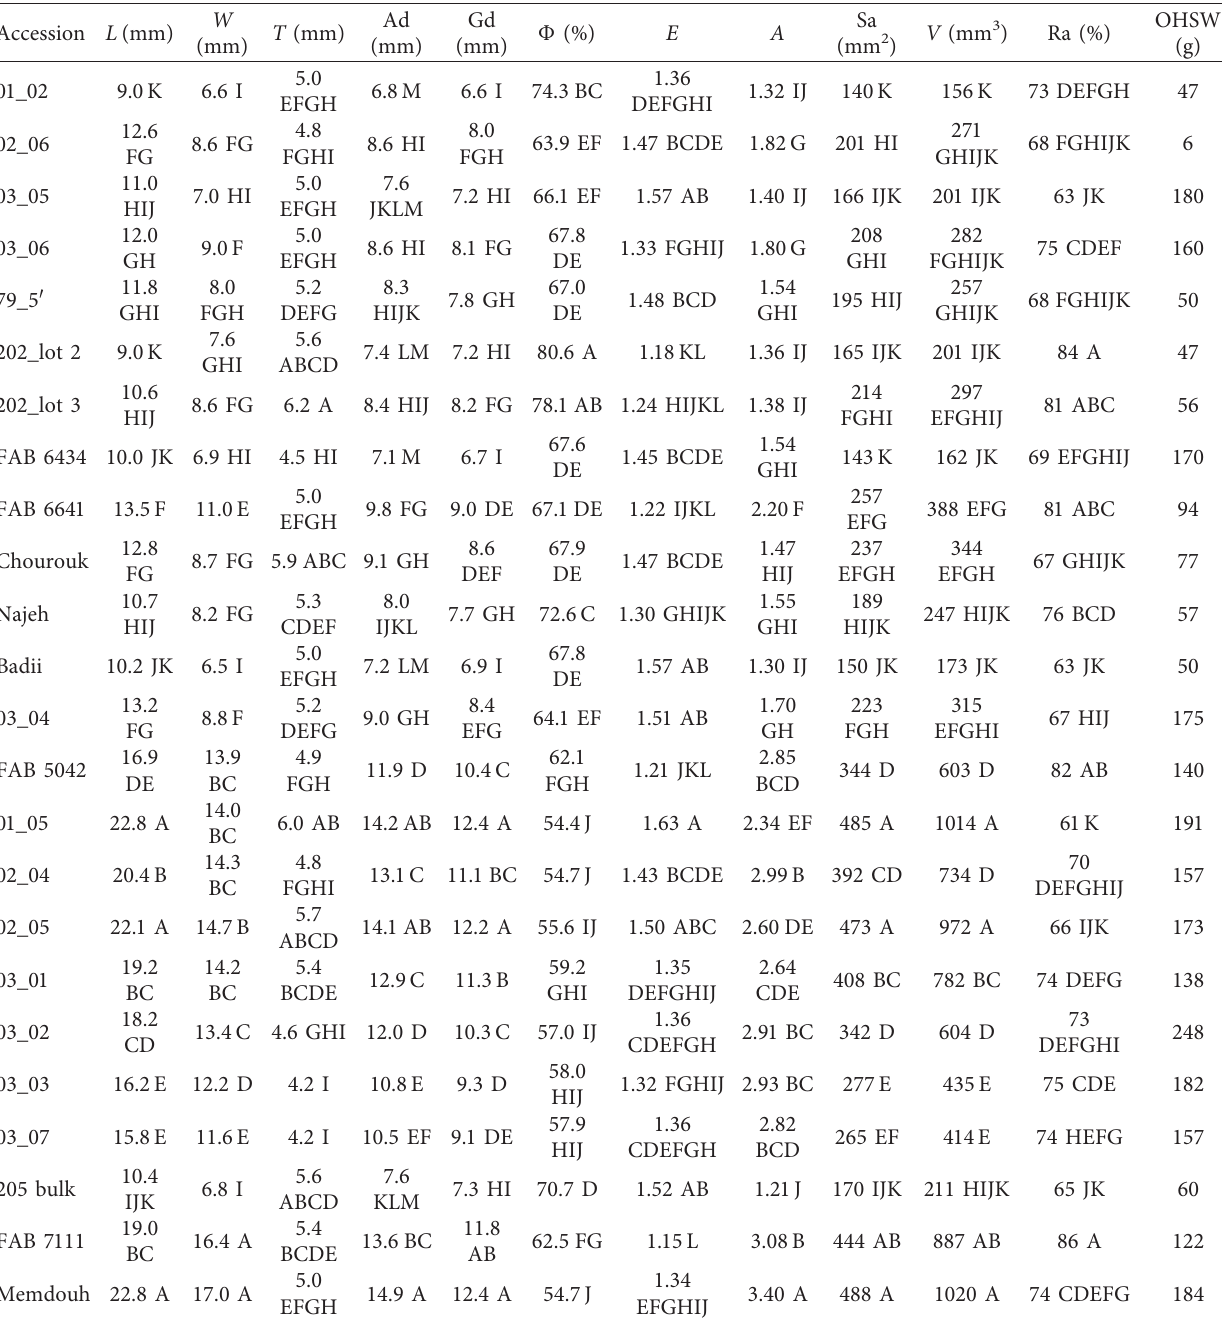
Table 2: Morphophysical parameters of 24 faba bean seed